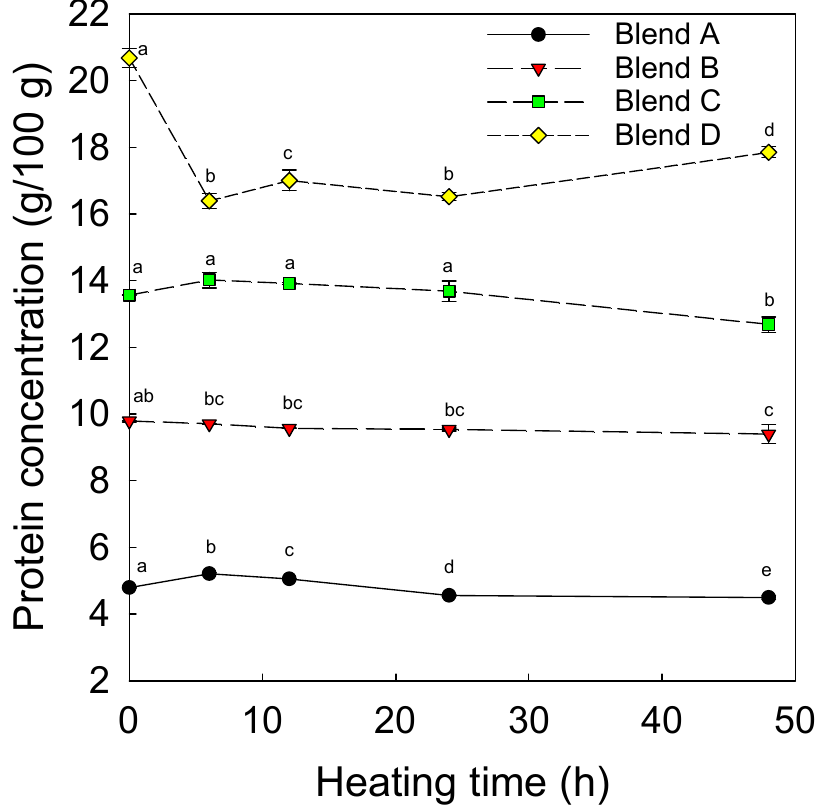
Figure 3. Protein content (mean ± standard deviation) for electrospun fibers from blend A (80:10:5), B (80:10:10), C (80:10:15), and D (80:10:20) as a function of heating time (the different letters indicate significant differences ( p < 0.05).